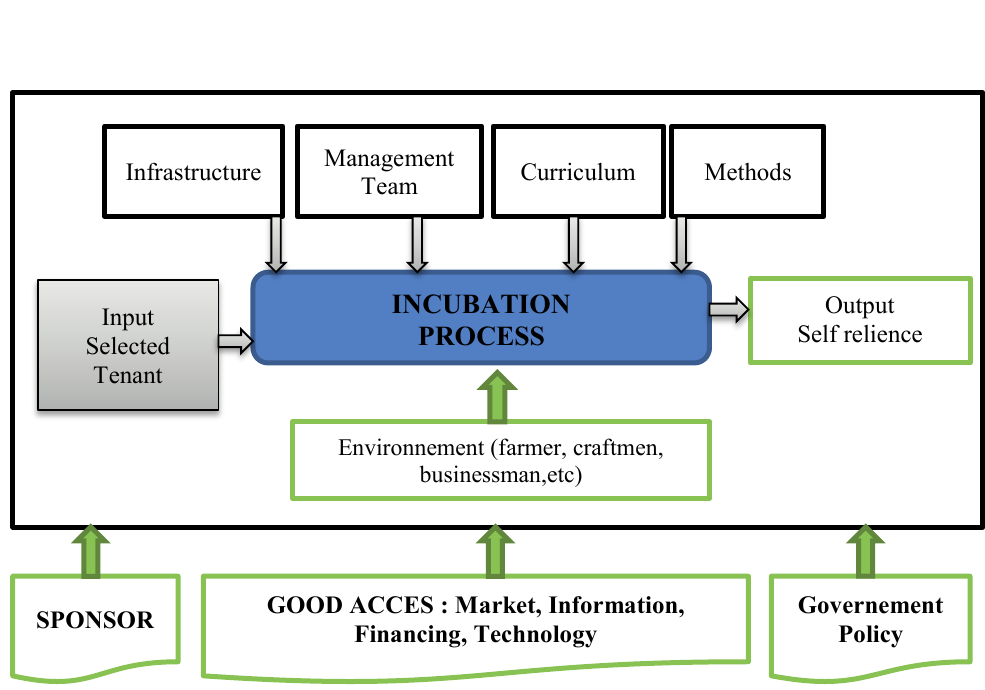
Fig. 1. The process of business incubation (Setiawan & Fahmi,